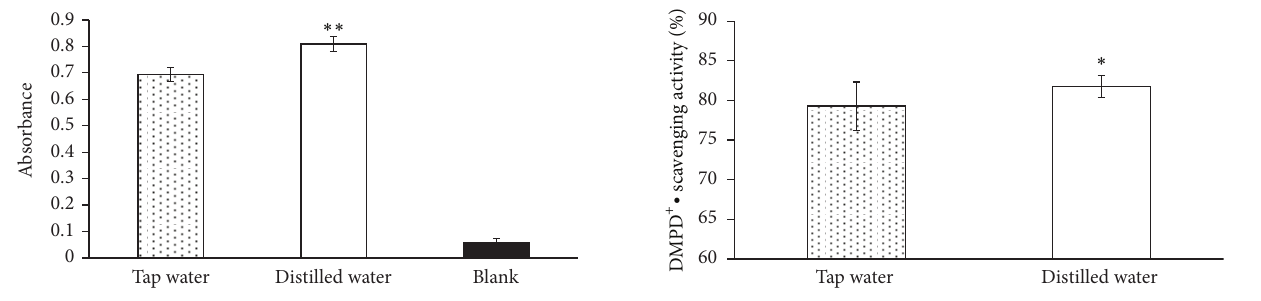
Figure 1: Effects of water solution on the total phenol content of green tea.